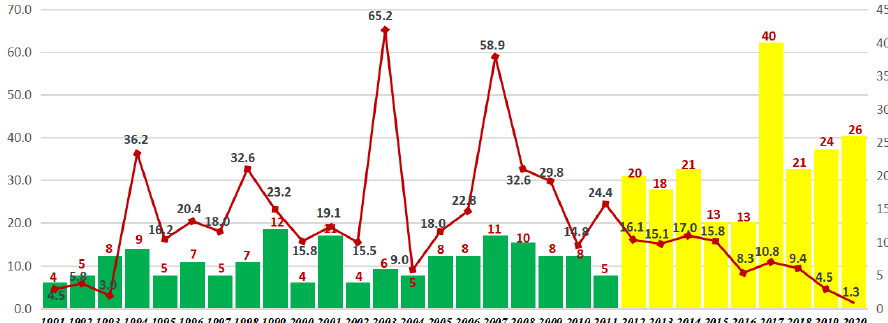
Figure 2. Agricultural-terrace research articles and citations during 1991 –